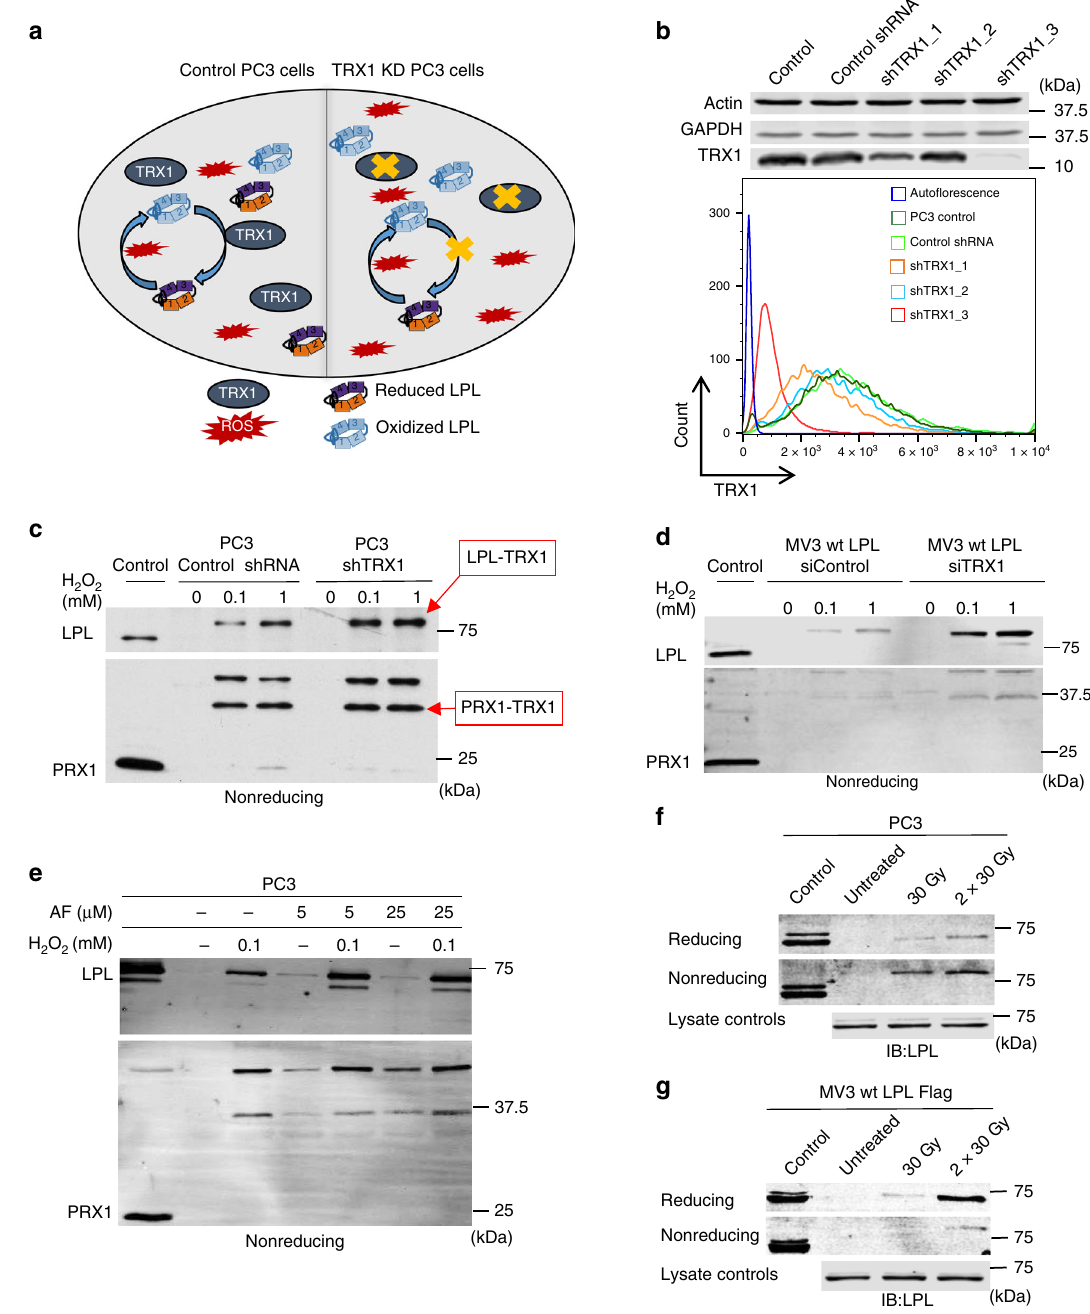
Fig. 3 TRX1 regulates LPL oxidation in prostate cancer and melanoma cells. a Schematic representation of the reduction of oxidized LPL in control (wt) PC3 cells (left) and in TRX1 knockdown PC3 cells (right). b Immunoblots (upper panel) and fl ow cytometry histograms (lower panel) showing stable knockdown of TRX1 in PC3 cells. PC3 cells were transduced with TRX1-targeting shRNAs or control shRNAs ( n = 5). c Immunoblot showing the TRX1 trapping of LPL and PRX1 in control and TRX1 knockdown PC3 cells. The trapping was performed as described. Shown are nonreducing gels ( n = 4). d Immunoblots of TRX1 trapping of LPL and PRX1 in MV3 cells. MV3 cells stably expressing LPL-FLAG constructs were transfected with siTRX1 or control siRNA. Thereafter, trapping was performed as described ( n = 3). e Immunoblot of TRX1 trapping of LPL and PRX1 upon inhibition of TRXR1 in PC3 cells with aurano fi n ( n = 3). f PC3 cells and g wt LPL-FLAG-expressing MV3 cells were either kept untreated or were irradiated with 30 Gy or 60 Gy for 10 min. The cells were then subjected to TRX1 kinetic trapping ( n =